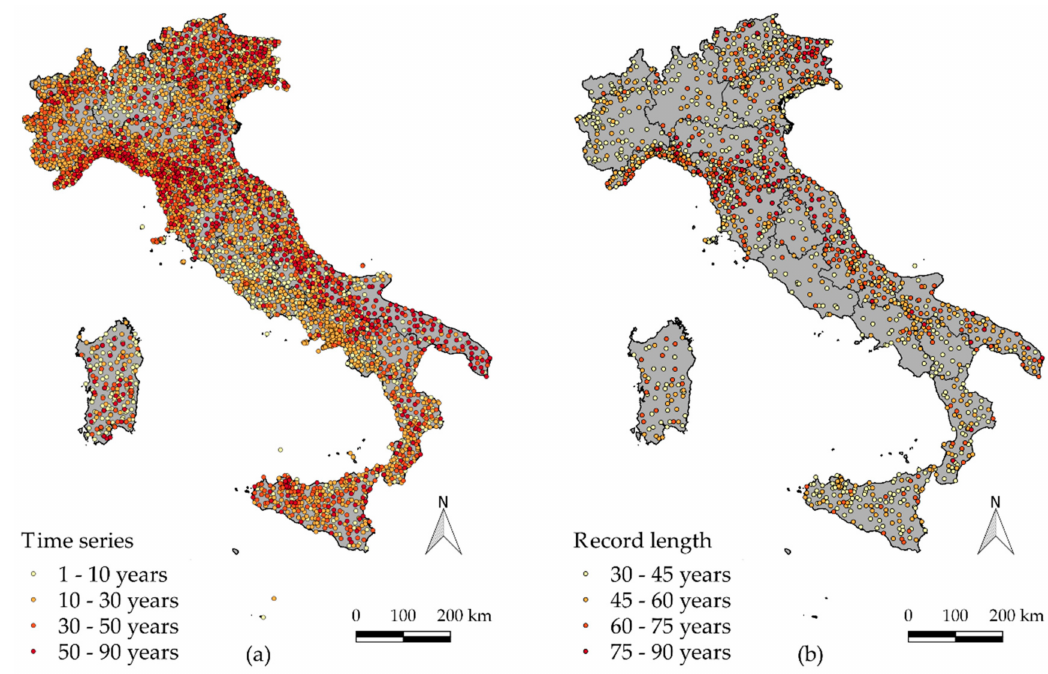
Figure 5. ( a ) Position of the rain gauges in I 2 -RED. The color refers to the length of the time series. ( b ) Spatial distribution of the rain gauges with a time series longer than 30